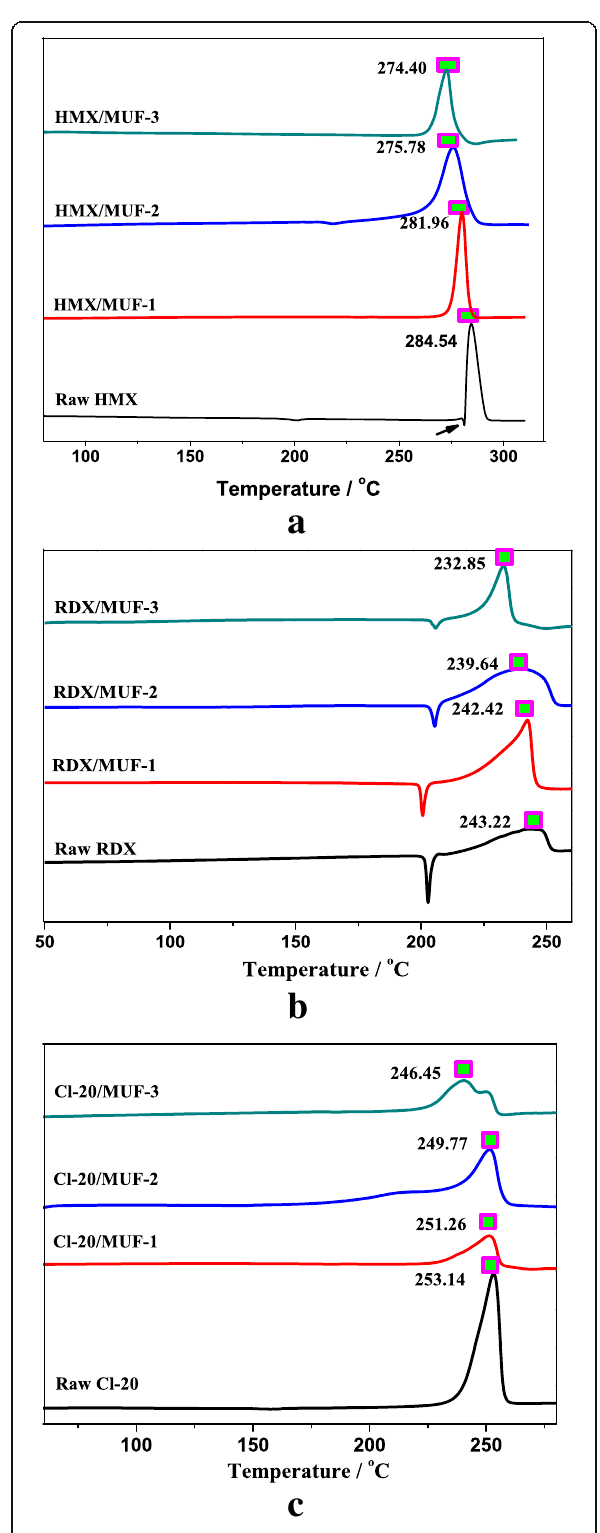
Fig. 7 a – c DSC curves of samples collected at a heating rate of 10